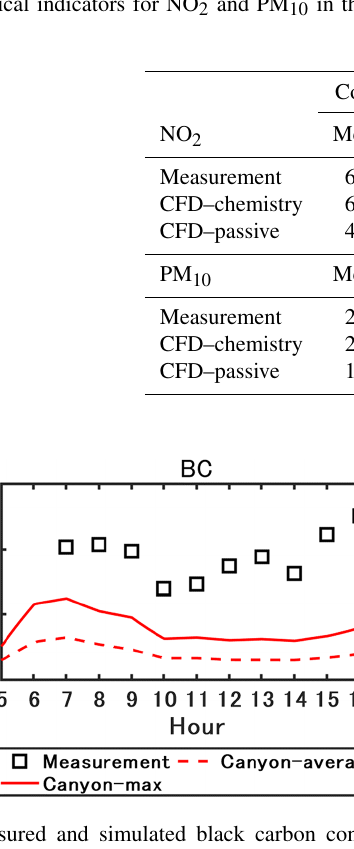
Figure 6. Simulated particle concentrations with OpenFOAM (OF) and Code_Saturne (CS). CFD–passive and CFD–chemistry denote the CFD simulation without and with chemistry coupling, respec-